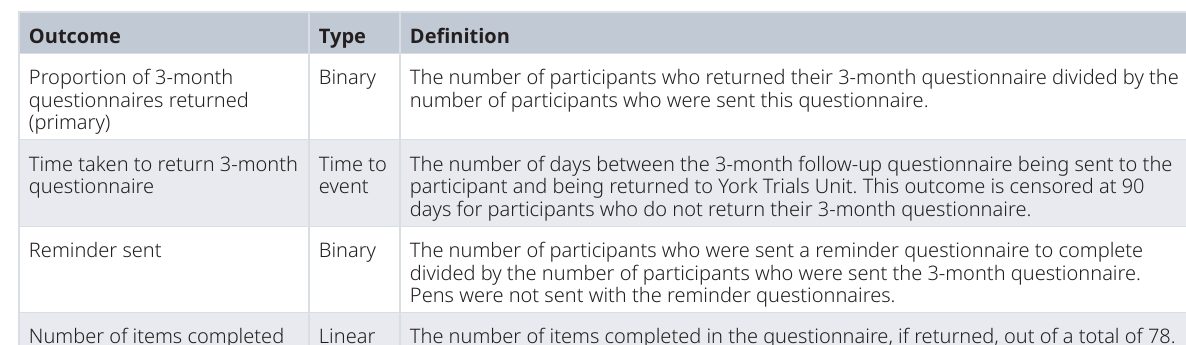
Table 1. Outcome measures of the